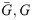
Effectiveness of Immunization Strategies at Different Levels of Missing Data and Immunization Coverage.Data points represent the difference in the mean final outbreak size of random immunization and each targeted immunization strategy (in percent of the population). Error bars were omitted because marker size was larger than 95% confidence intervals on the mean (5000 individual networks with 2000 SIR simulations for each). With β = 0.95, this ensemble of networks had a measured R0 value of 4.85 (computationally assessed [76]). When no immunization was applied, the mean outbreak size was 58.12% of the population. Data points were omitted if a strategy was ever unable to converge to that level of immunization coverage, i.e., when there were not enough candidates to immunize. The legend lists all strategies tested: betweenness (Bet), degree (Deg), self-reported degree (S.R.D), and all variants of acquaintance immunization (Acq(G′, G′), Acq(G′, G), Acq(G¯,G), and Acq(G, G)).